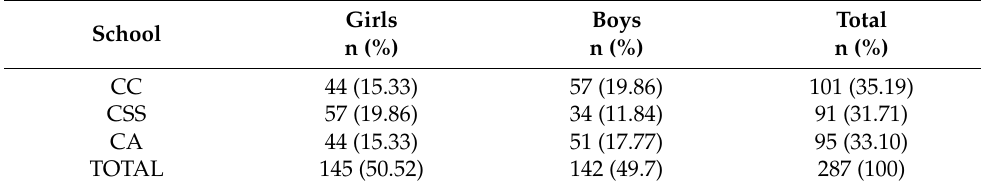
Table 1. Distribution of the sample, according to school and